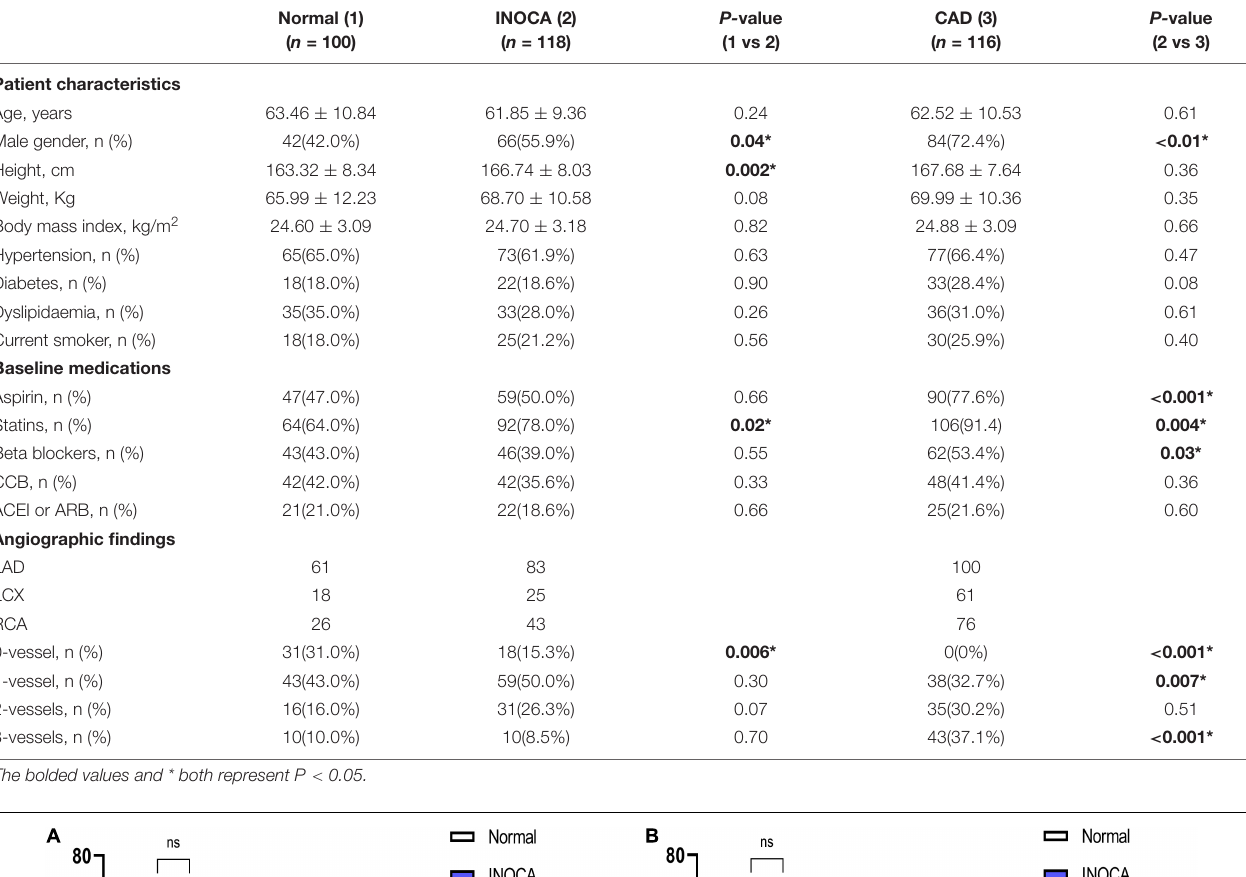
TABLE 1 | Clinical characteristics of the study population ( n = 334).